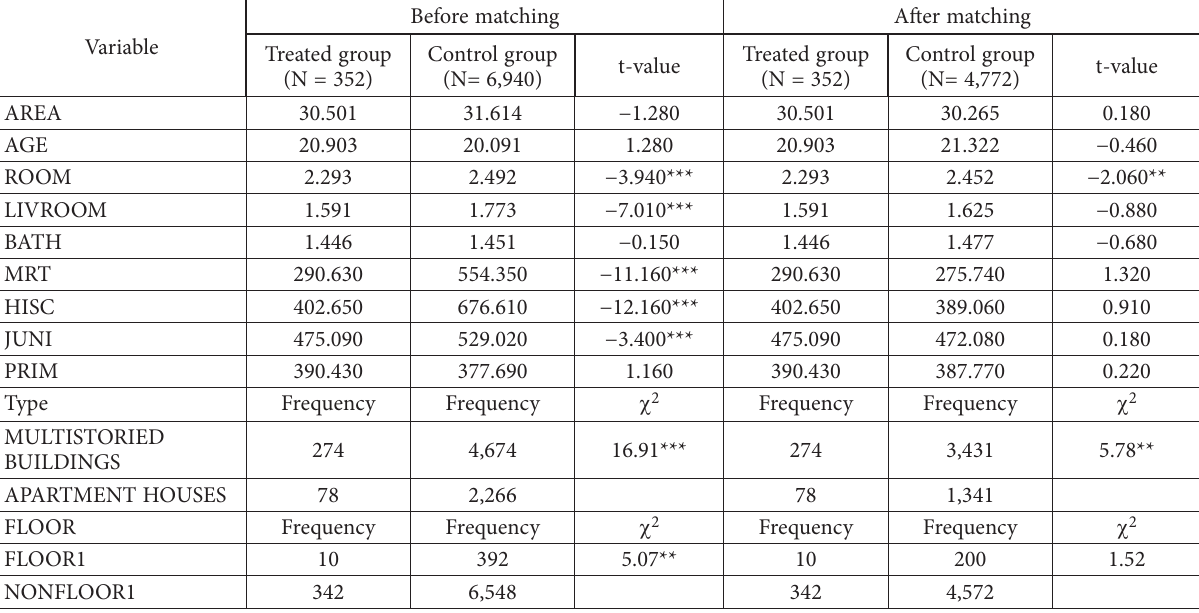
Table 2. Differences in mean values between the experimental group and the control group during construction